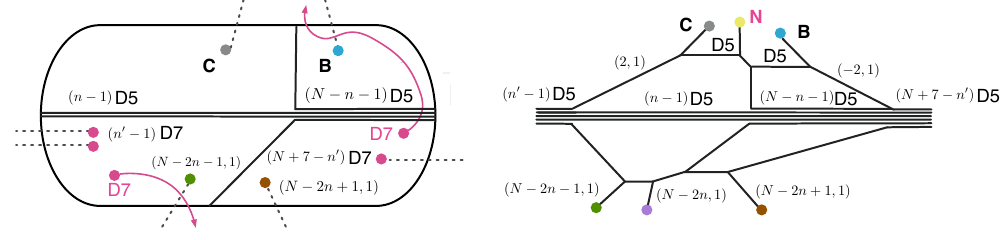
Figure 10 . Left: the two O 7 (cid:0) planes in (cid:12)gure 8 is resolved. Right: web-diagram obtained by moving all the 7-branes